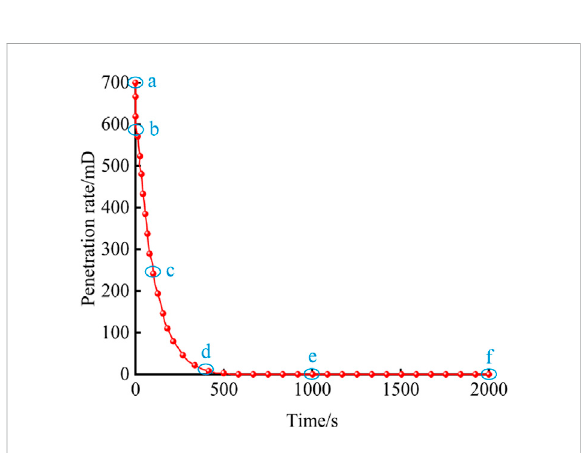
FIGURE 13 Permeability of coal sample fracture with time.